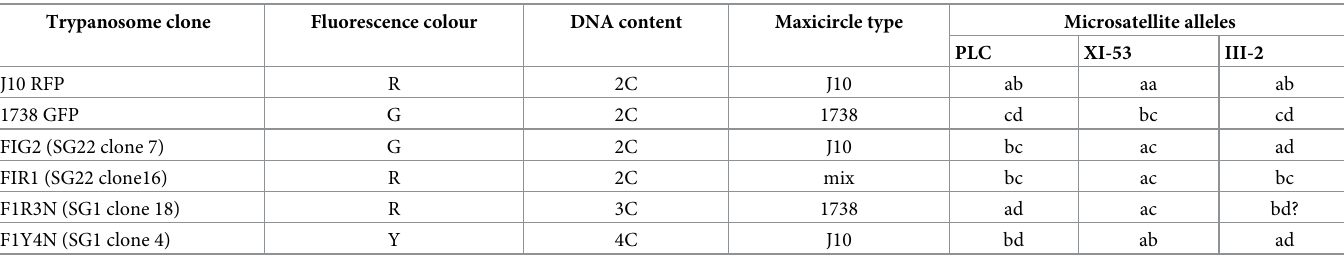
Table 1. Attributes of parental and hybrid clones.